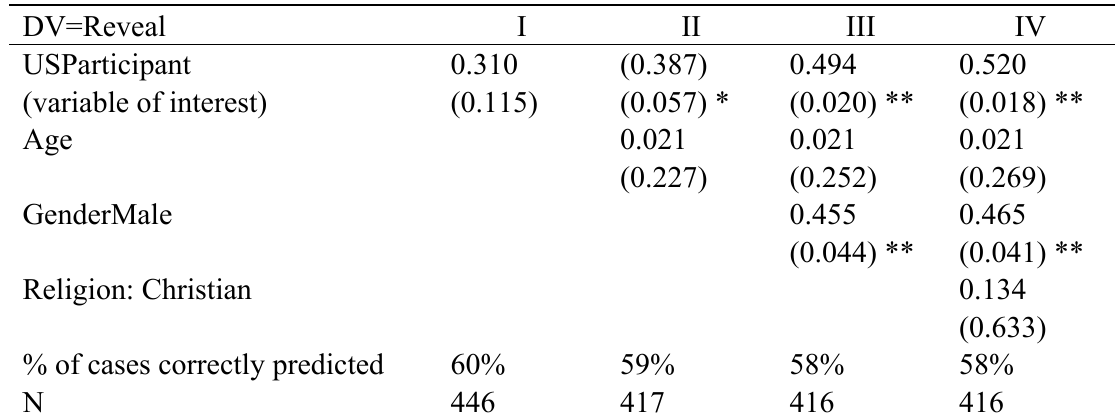
Table 3. Logit Regression of Country Location and Choice to Reveal Saboteurs.